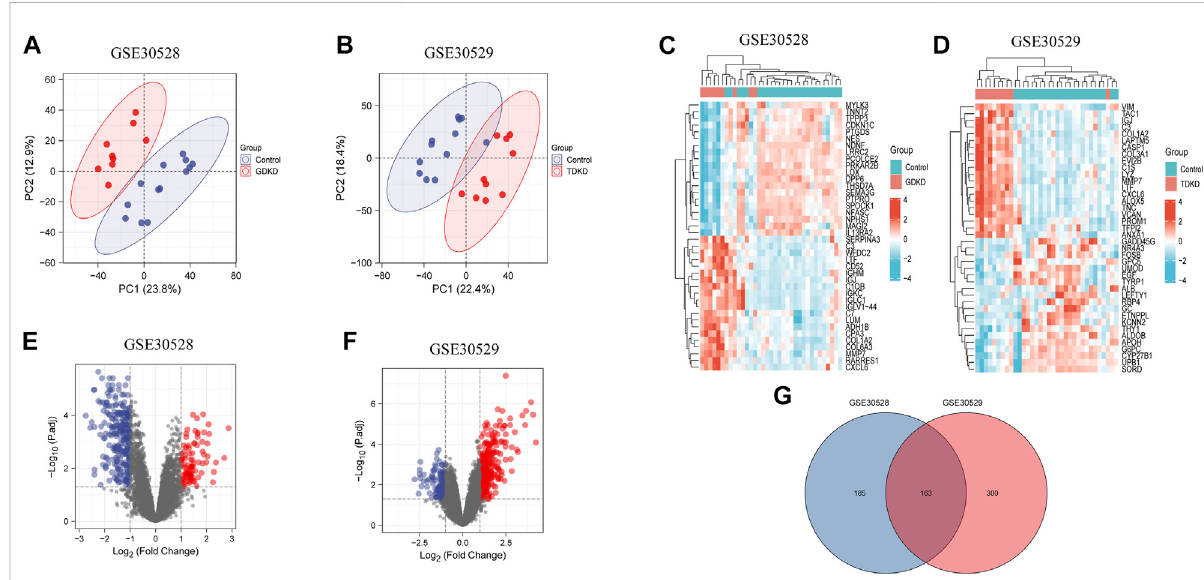
FIGURE 1 PCA analysis and DEGs identi fi cation in GSE30528 and GSE30529. (A) PCA of glomerular samples in GDKD (GSE30528). Red dots represent the PCA values of nine glomerular samples in GDKD group, and the blue dots represent the PCA values of 13 glomerular samples in control group. (B) PCAoftubulointerstitialsamplesinTDKD(GSE30529).ReddotsrepresentthePCAvaluesof10tubulointerstitialsamplesinTDKDgroup,andblue dots represent the PCA values of 12 tubulointerstitial samples in control group. (C) Heatmap shows the top 20 signi fi cantly upregulated and downregulated DEGs in GSE30528. (D) Heatmap shows the top 20 signi fi cantly upregulated and downregulated DEGs in GSE30529. (E) Volcano diagram of GDKD included 348 DEGs. Red circles represent 93 upregulated DEGs, and blue circles represent 255 downregulated DEGs. (F) Volcano diagramofGSE30529included463DEGs. Redcircles represent 340upregulatedDEGs, andthebluecirclesrepresent123downregulated DEGs. (G) Venn diagram shows the overlapped DEGs between GDKD and TDKD. GDKD: glomerular diabetic kidney disease; TDKD: tubular diabetic kidney disease; PCA: principal component analysis.